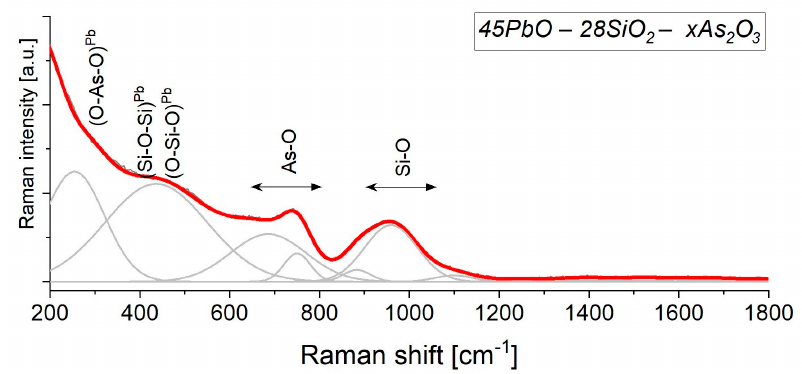
Figure 6. Raman spectrum of 45PbO-28SiO 2 -xAs 2 O 3 glass measured from Ruda Ś l ą ska slags. A peak-fitting analysis was done using Voigt function with preservation of the minimum number of components .